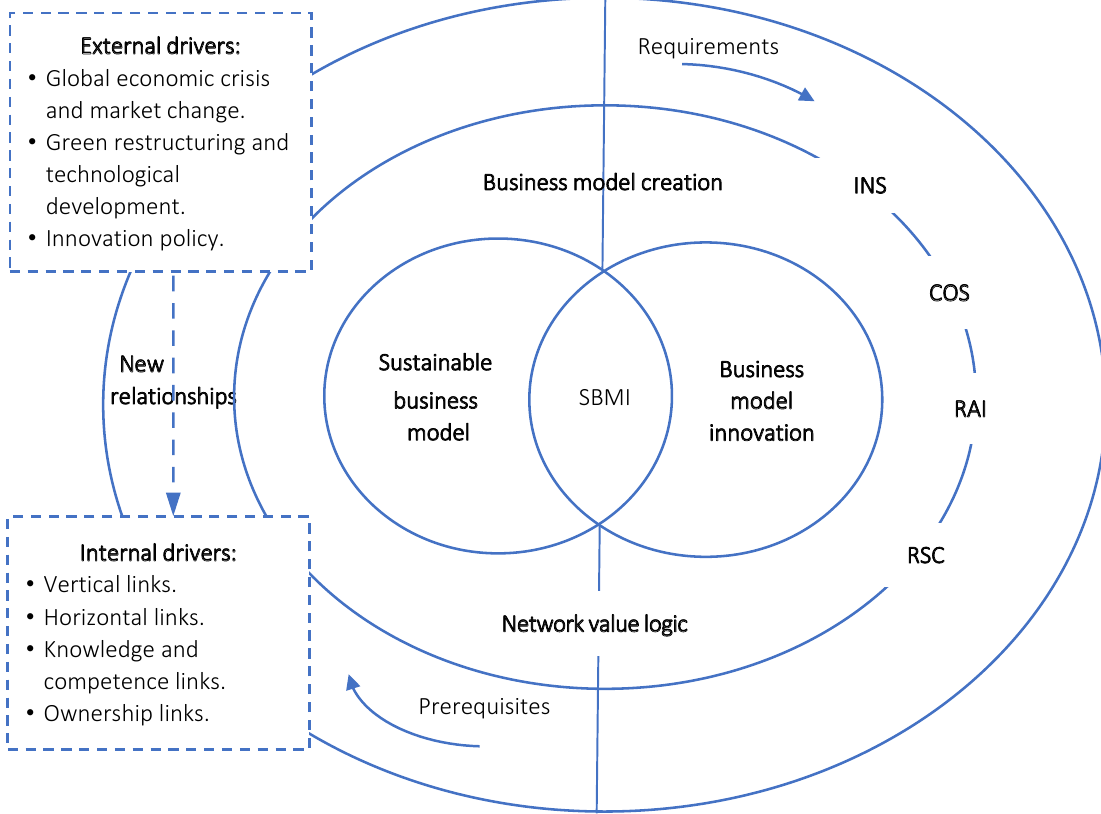
Figure 3. Theoretical framework: prerequisites and requirements for creating a business model (network value